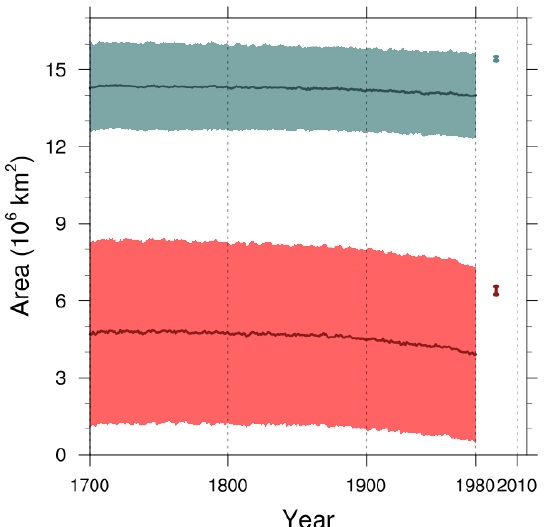
Figure 14. Maximum (March – blue) and minimum (September – red) sea ice area ensemble mean ± one standard deviation. The ver- tical lines represent observational 1981–2010 March and September mean sea ice area within one standard deviation (Walsh et al.,